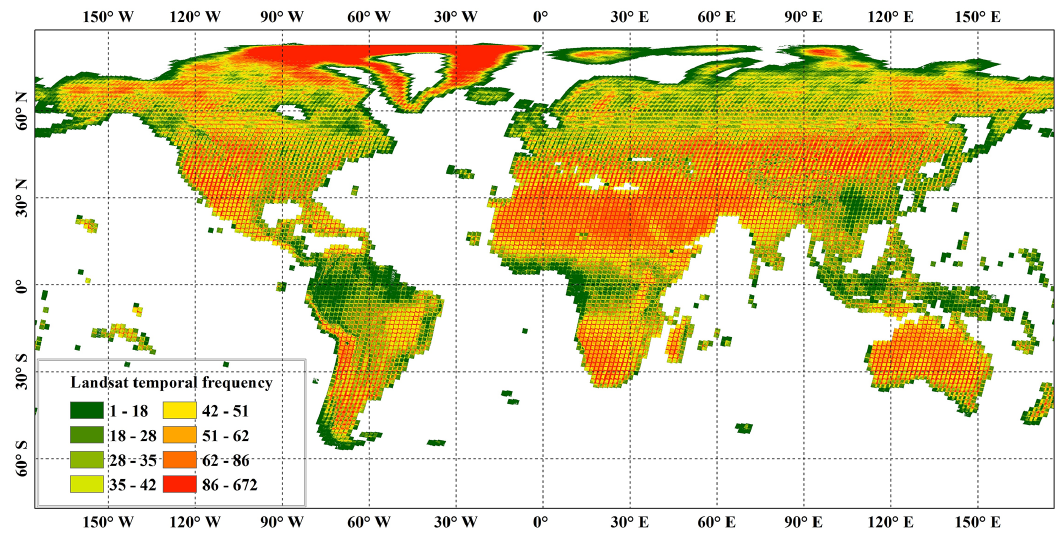
Figure 1. The availability of clear-sky Landsat SR imagery for the years 2014–2016 on the GEE